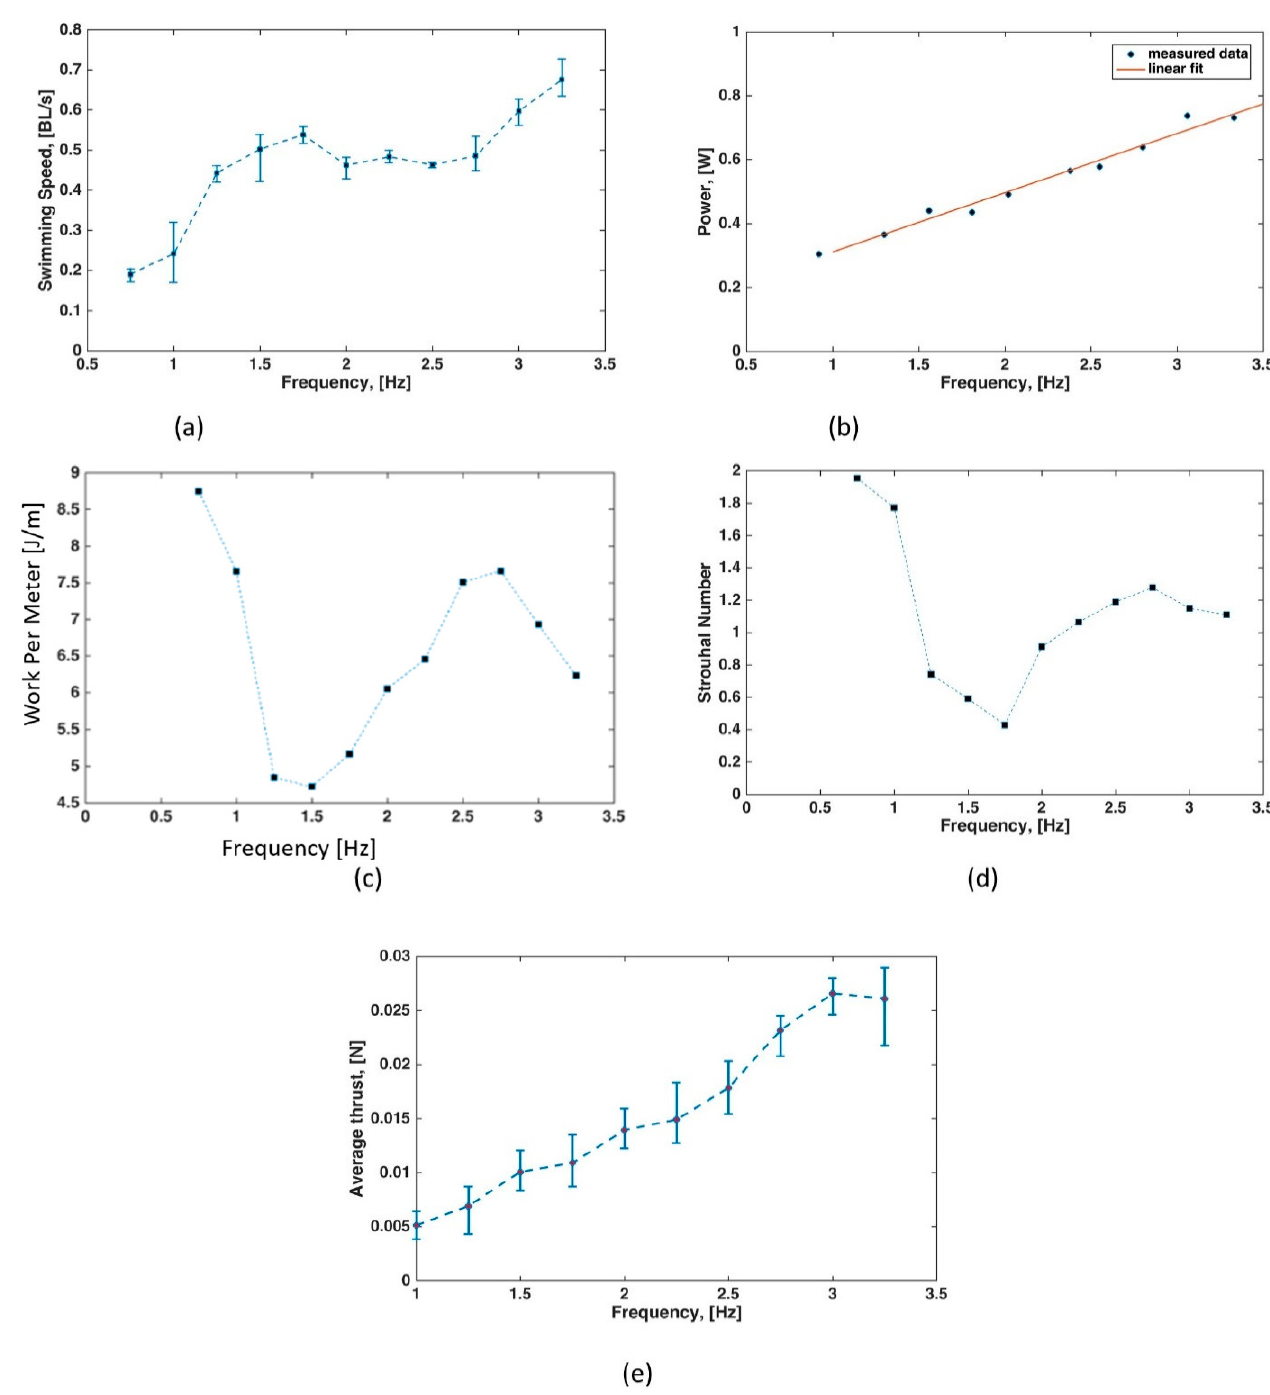
Figure 11. Performance graphs. ( a ) Swimming speed (in BL/s ) versus tail beat frequency (in Hz ). Points are the means of four swimming trials. Error bars denote maximal and minimal values. The average swimming speed increased approximately linearly with the tail beat frequency. A sharp local increase in swimming speed was seen from 1 to 1.75 Hz , followed by a dip. The swimming speed remained almost constant from 2 to 2.75 Hz . Then, it again increased linearly with frequency. ( b ) Power consumption by the motor (in watts) versus tail beat frequency (in hertz). ( c ) Energy (in joules) required to travel 1 meter versus tail beat frequency (in hertz). ( d ) Strouhal number versus tail beat frequency (in hertz). ( e ) Thrust (in newton) versus tail beat frequency (in hertz). Points are the means of four swimming trials; error bars denote maximal and minimal values.